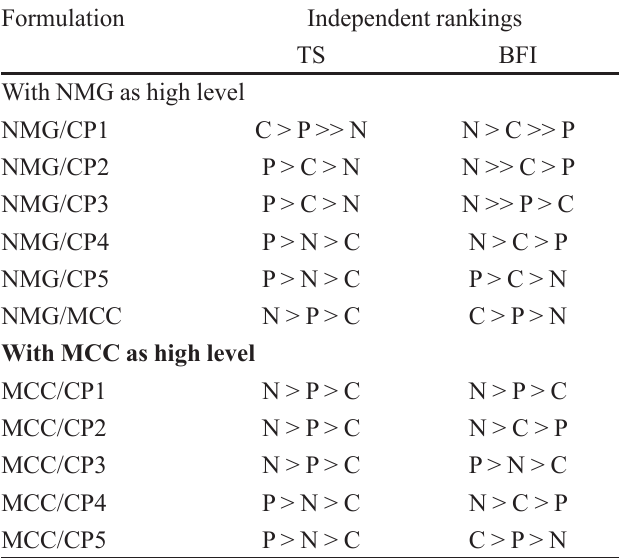
TABLE V - Rankings obtained for the independent coefficient effects on the TS and BFI of tablets Formulation Independent